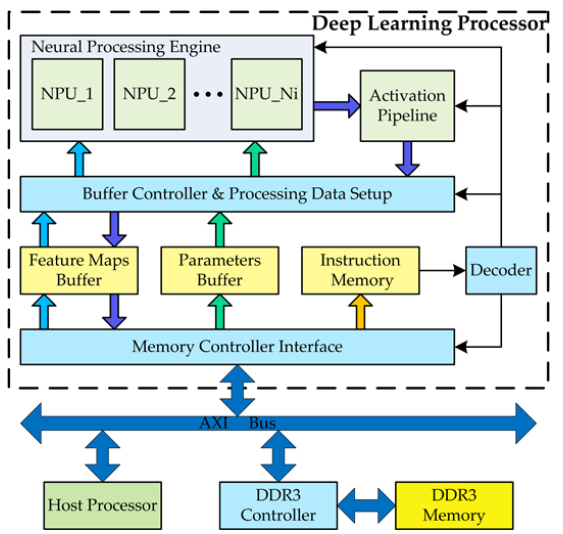
Figure 3. The overall diagram of the designed hardware architecture of the deep learning processor.